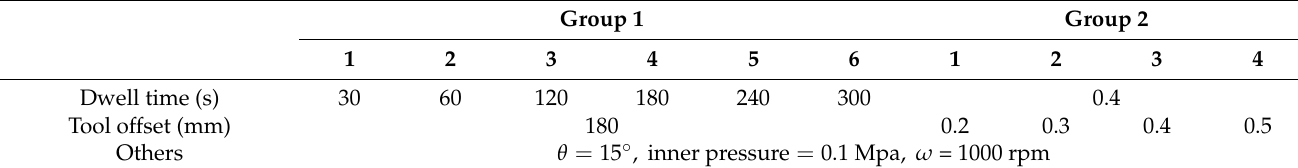
Figure 4. Schematic of bonnet tool polishing model. Table 2. TIF generation conditions.